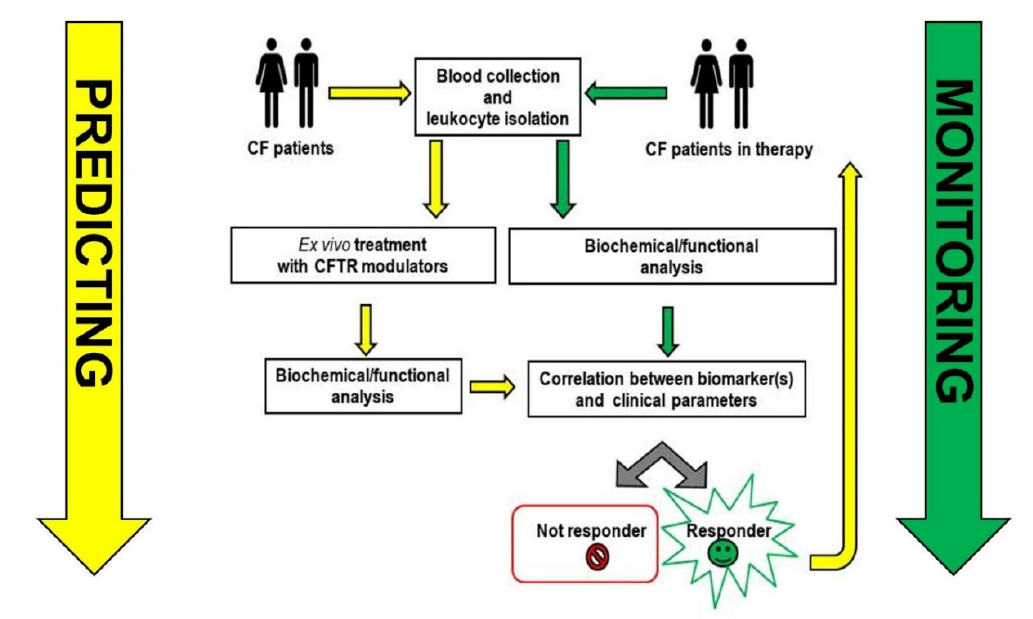
Figure 1. A possible application of leukocyte analysis in the context of the prediction and monitoring CF disease.